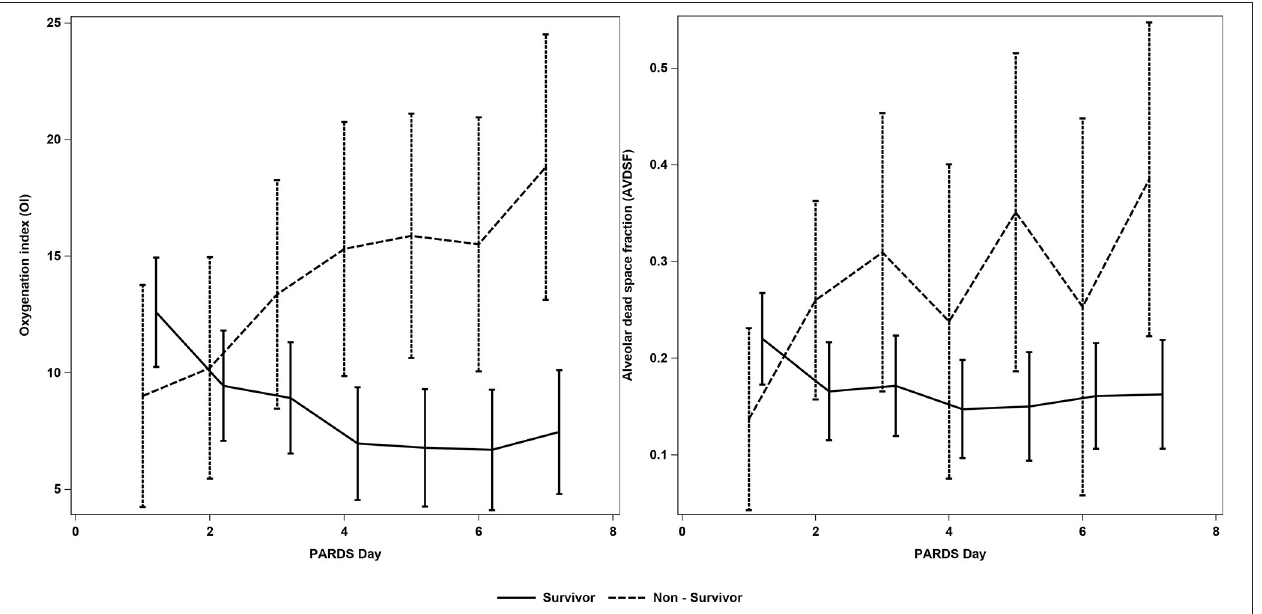
TABLE 2 | Clinical outcomes across high and low AVDSF groups. Outcomes Total Multiorgan dysfunction*